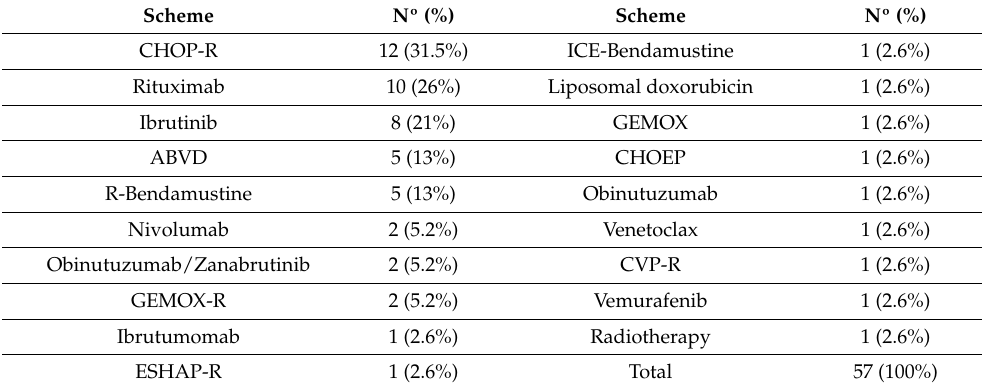
Table 2. Distribution of treatments received by the